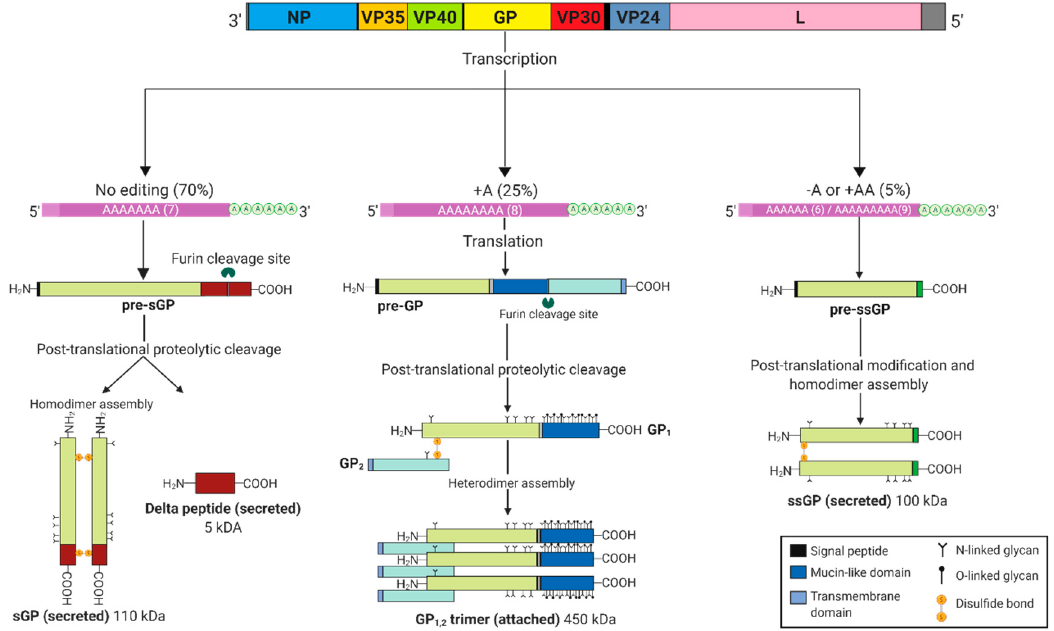
Figure 2. Ebolavirus GP gene products. Co-transcriptional editing at the GP gene editing site results in three major transcripts that are afterwards translated to various glycoprotein products, initially synthesized as pre-sGP, pre-GP and pre-ssGP. Post-translational cleavage by furin at the carboxy terminus of pre-sGP generates a 5 kDa delta ( Δ )-peptide and an sGP monomer that further assembles into a 110 kDa homodimer linked by two disulfide bonds. Similarly, pre-GP (also known as GP 0 ) undergoes a proteolytic cleavage resulting in the formation of a disulfide linked GP 1,2 heterodimer that trimerizes into a 450 kDa viral surface glycoprotein. Pre-ssGP does not undergo post-translational